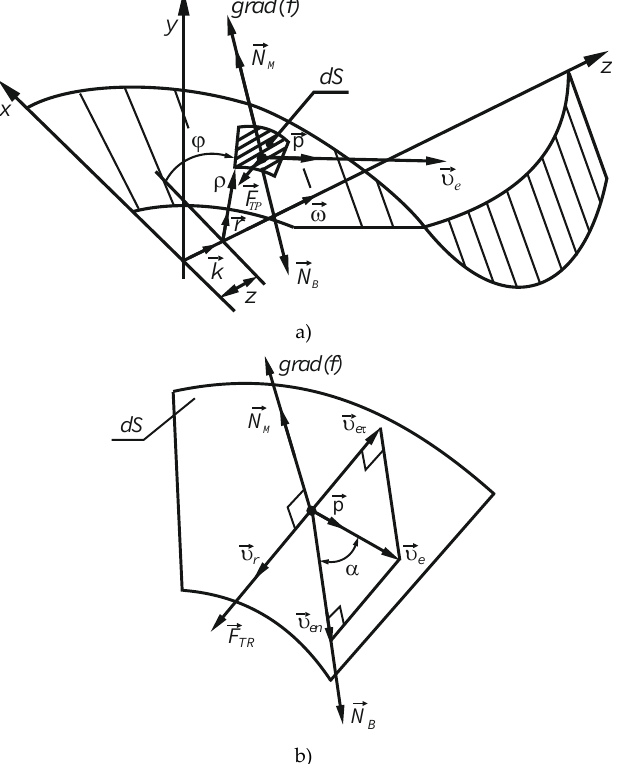
Figure 6. Schematic representation of interaction between the screw surface and the material in the mixer: ( a ) axes of coordinates and forces, ( b ) elementary area – a segment of the screw surface and material rate; grad ( f ) is the gradient vector to the surface f ; 𝑟⃗ , 𝑝⃗, 𝑘⃗⃗ are the cylindrical unitary vec- tors; dS is the elementary area; 𝑁⃗⃗⃗ 𝐵 is the force with which an elementary area of the screw surface impacts the material when in steady motion; 𝑁⃗⃗⃗ 𝑀 is the normal force; 𝜔⃗⃗⃗ is the angular velocity; 𝑣⃗ 𝑒 is the transfer velocity; 𝑣⃗ 𝑟 is the relative velocity; φ is the angle of screw interaction with material and ρ is the screw radius.